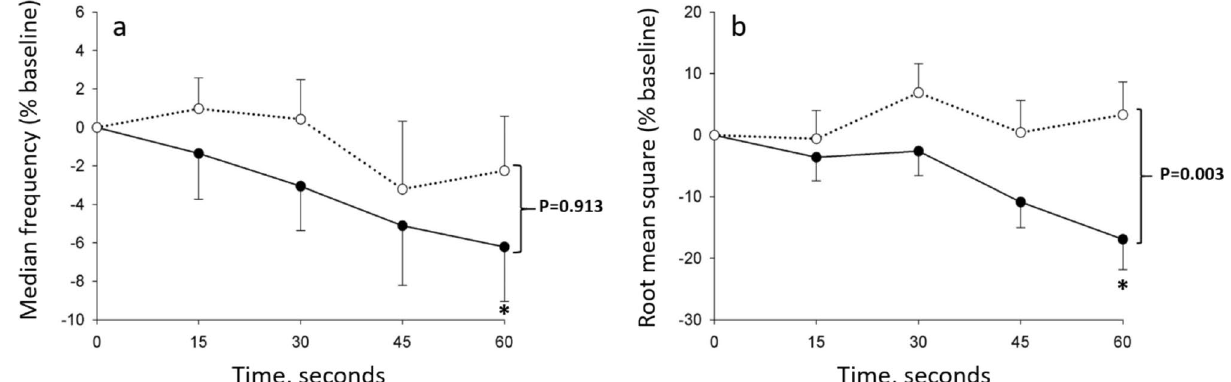
Figure 4. Changes in quadriceps ( a ) median frequency and ( b ) root mean square during the 1-min sit-to-stand (1STS), expressed in % baseline value in people with COPD (full circles) and healthy controls (open circles). Results are presented as mean ± SEM. * p < 0.01, 60 s compared to 15 s. The p values report the interaction group × time during the